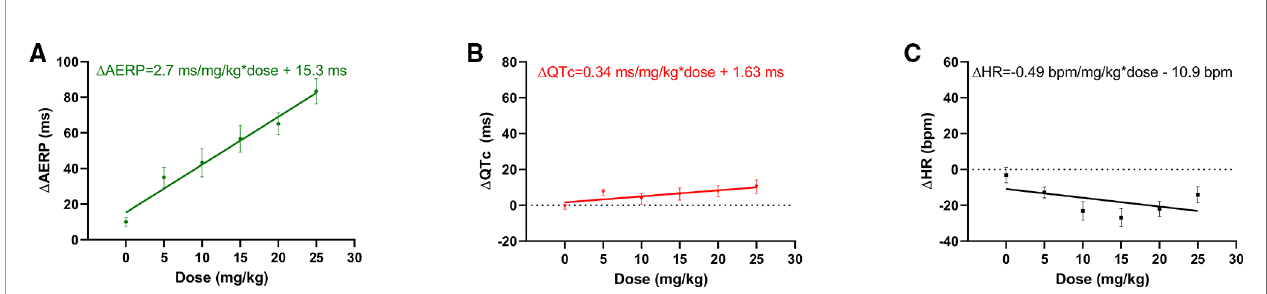
FIGURE 5 | Simple linear regression of (A) D AERP, (B) D QTc, (C) D HR from start to end of infusion of AP30663 as a function of dose with simple linear regression. Departure from linearity was tested with a replicate test. All slopes were signi fi cantly different from zero (p < 0.001, p = 0.018, and p = 0.49 for D AERP, D QTc, and D HR, respectively). No evidence was found of nonlinearity for D AERP and D QT as functions of dose (p = 0.721, and p = 0.604, respectively), but D HR as a function of dose deviated signi fi cantly from linearity (p = 0.019). AERP, Atrial effective refractory period; QTc, QT interval corrected for heart rate, HR, Heart rate.